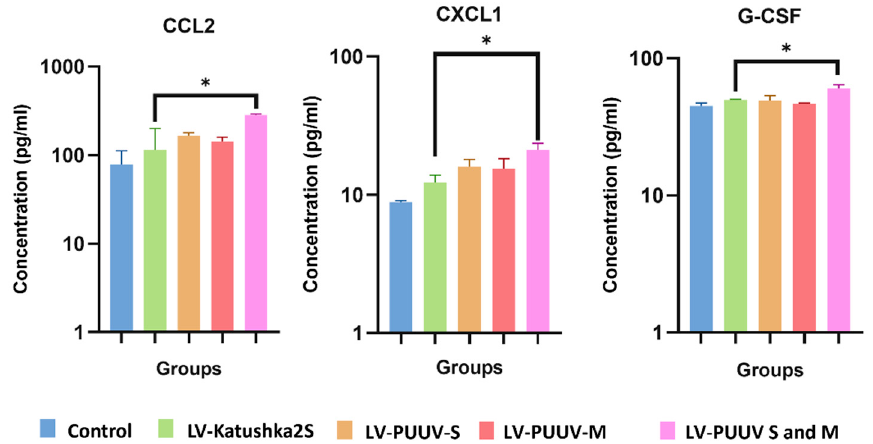
PUUV N; lane B3—PUUV N and Gn/Gc. lane B2—MVs